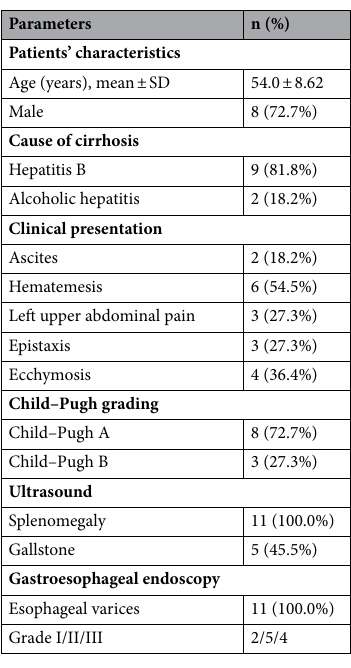
Table 1. Patients’ demographics, clinical presentation, abdominal ultrasound and gastroesophageal